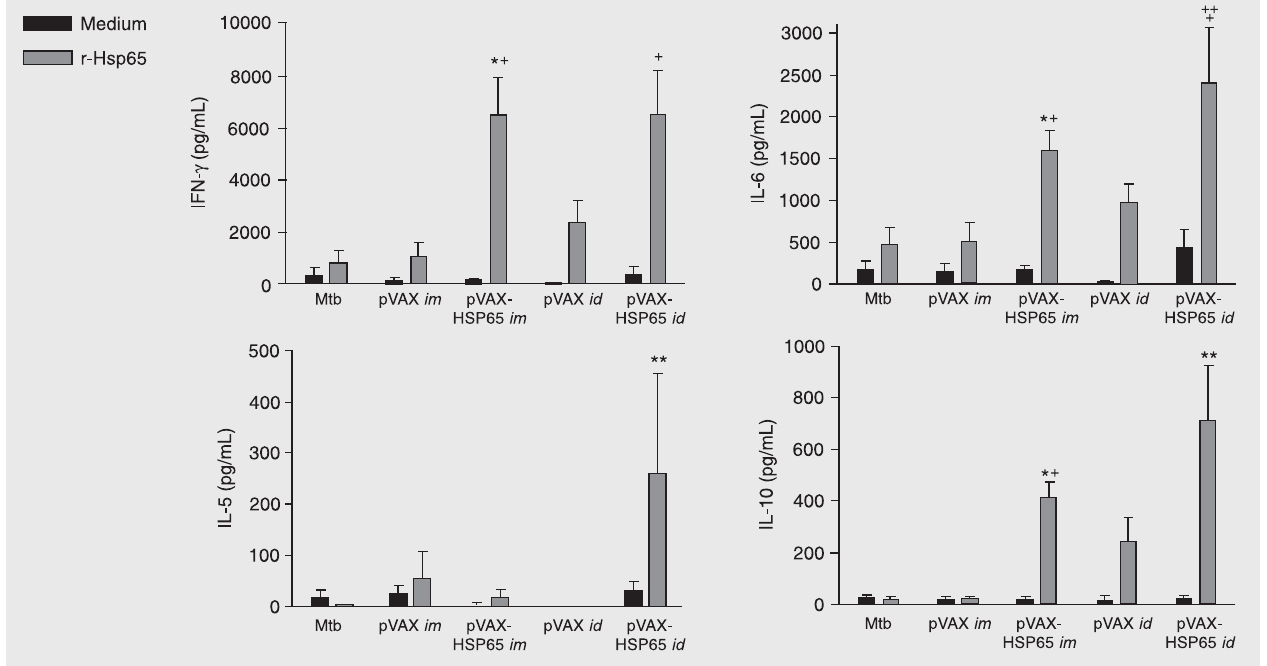
Figure 3. Cytokine production after specific stimulation with recombinant Hsp65 (r-Hsp65). Female C57BL/6 mice (4-6 mice per group) were fed for 105 days an atherogenic diet (high cholesterol diet, HCD) associated with 3 doses of 250 µg heat-killed M. tuberculosis (Mtb) on days 0, 15, and 30. On day 105, the animals started to receive a normal chow diet and were immunized with DNA (4 doses of 100 µg pVAX-HSP65) administered by the intramuscular ( im ) or intradermal ( id ) route on days 105, 115, 125, and 135. The following control groups (4-6 mice per group) were included: Mtb (animals fed the HCD and immunized with Mtb); pVAX im and pVAX id (animals fed the HCD, immunized with Mtb and injected with the empty vector by the im or id route). Fifteen days after the last DNA immunization (150th day), mice were sacrificed and spleen cell cultures were stimulated with r-Hsp65 for 48 h. Cytokines were measured in the culture supernatants by ELISA. Data are reported as mean ± SEM for 4-6 animals per group. + P < 0.05 compared with the Mtb group; ++ P < 0.05 compared with the pVAX id group; *P < 0.05 compared with the pVAX im group; **P < 0.05 compared with all other groups (ANOVA followed by Tukey